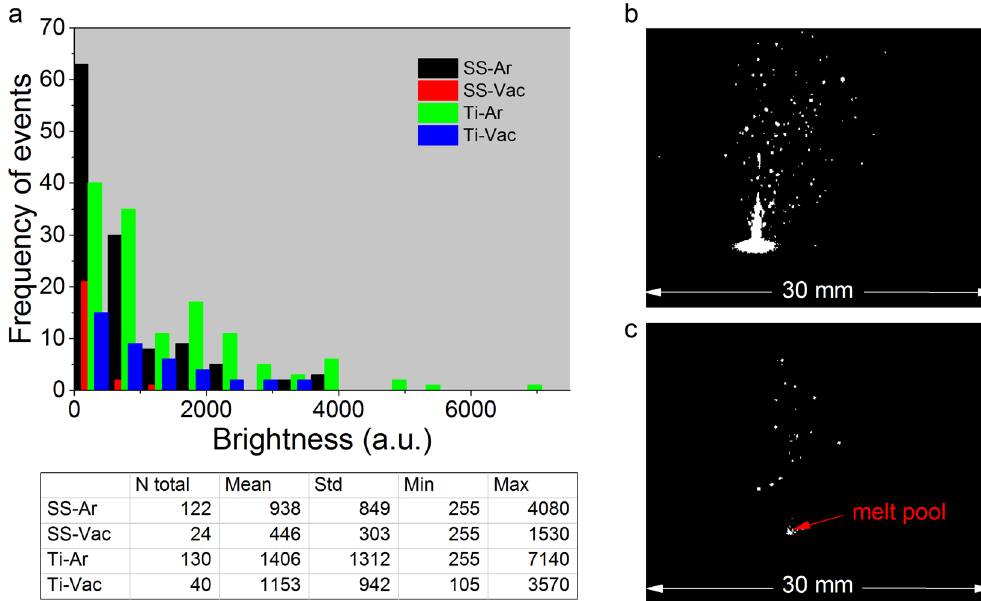
Figure 7. Comparison of spatter ejection for SS316L and Ti64 powder in 10 − 3 Torr Vac and 760 Torr Ar over 5 ms time frame. ( a ) Histogram of brightness which is taken as the sum of the total number photons (“N total”) above the background with bin size = 255. “Mean, Std, Min, Max” on the Table, indicates the mean, standard deviation, minimum and maximum brightness. For SS316L, in Ar, there are 5 × more ejections that appear with 2 × higher intensity. Ti64 had more ejections than SS316L in Ar and vacuum. Experimental images recorded for SS316L and shown in ( b ) argon and ( c ) vacuum were taken at a camera frame rate of 100 kfps and an exposure time of 8 μ s. Laser power P = 200 W, scan speed u = 1.5